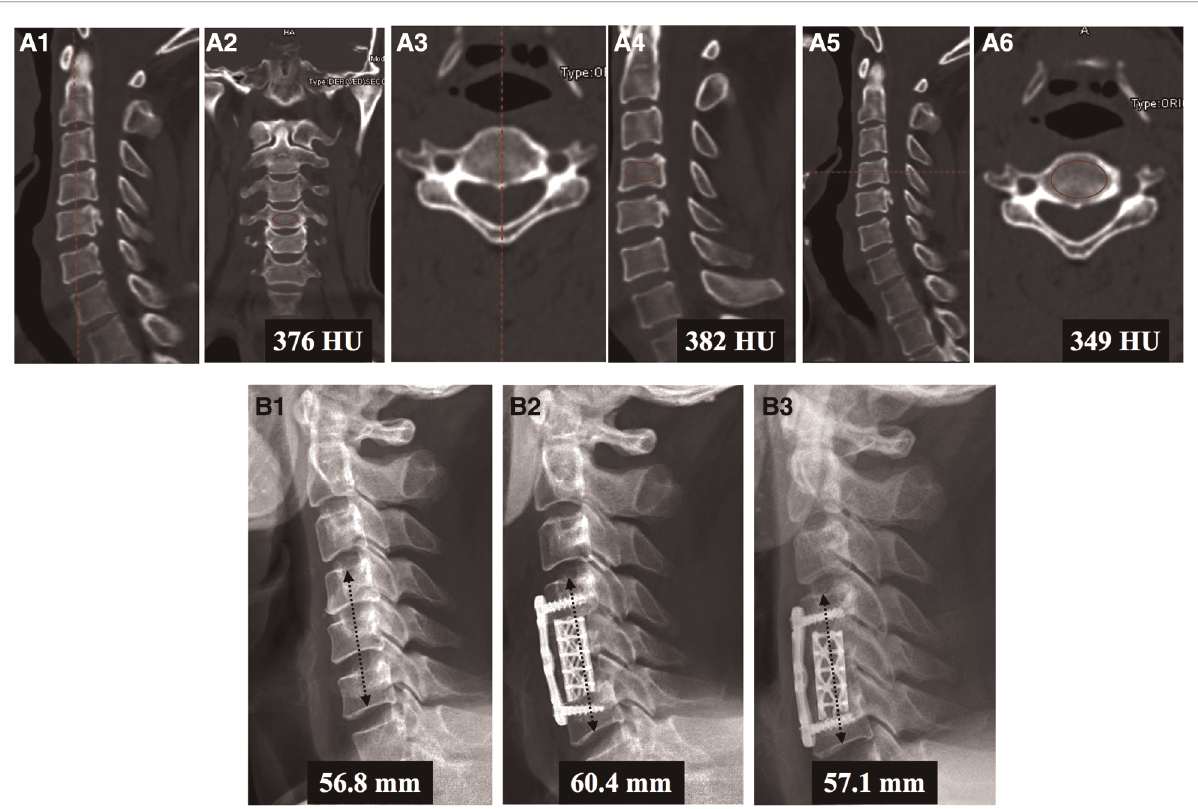
FIGURE 1 Measurement method of the HU value in C5 ACCF. ( A ) First, HU values of the C4 vertebral body were calculated. The HU values of the mid-sagittal ( A1,A2 ), mid-coronal ( A3,A4 ), and mid-axial ( A5,A6 ) planes were measured. The same method was used to calculate the HU values of the C6 vertebral body. ( B ) Illustration of the method for measuring disc height. Disc height was de fi ned as the straight line between the midpoint of the lower endplate of the upper vertebra and the midpoint of the upper endplate of the lower vertebra. Disc height was measured before surgery ( B1 ) and within 3 days after surgery ( B2 ) and at the fi nal follow-up ( B3 ). This patient was assessed to have subsidence due to height loss greater than 3 mm at the fi nal follow-up (1.5 years after